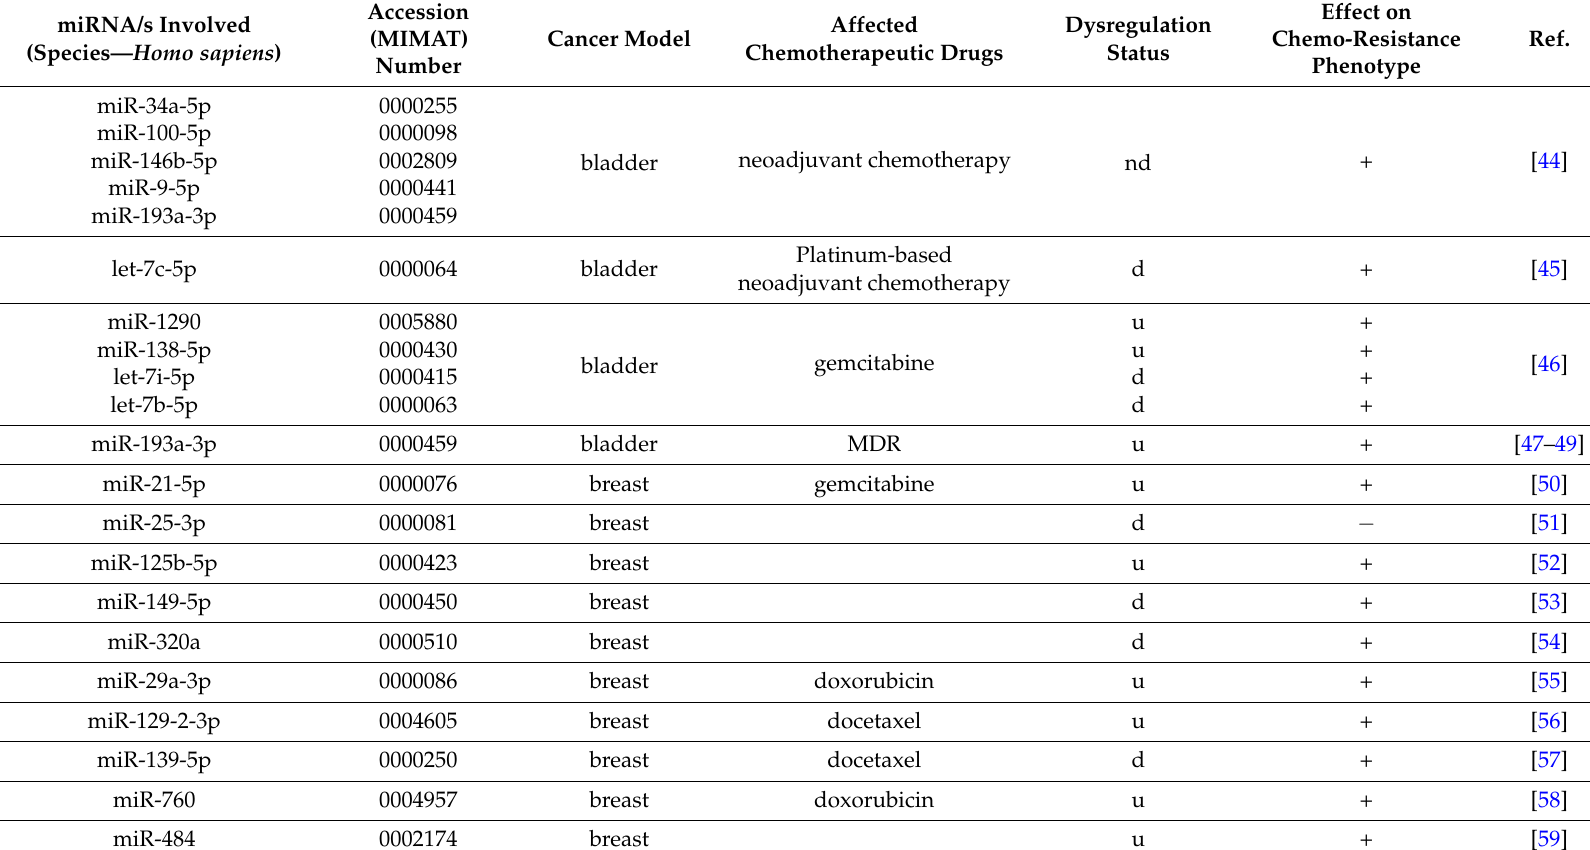
Table 1. Compendium of miRNAs identified to influence cancer chemoresistance since 2013, either as oncomiRs or as tumour suppressors. A details list of additional such miRNAs, identified prior to 2013, can be obtained through the open-access review publication by Garofalo and Croce [42]. Furthermore, due to recent changes in miRNA annotation and nomenclature, the putative miRNAs mentioned in the literature have been listed according to the latest annotation changes on the miRBase repository, using the miRBase tracker webtool (annotation history of mature miRNA searches) [43]. Table keys: u, Upregulated; d, Downregulated; nd, not described; +, Increase; − ,